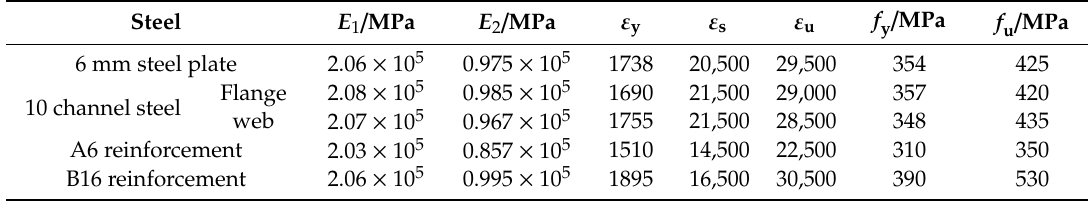
Table 2. Mechanical performances of steel and stirrup.